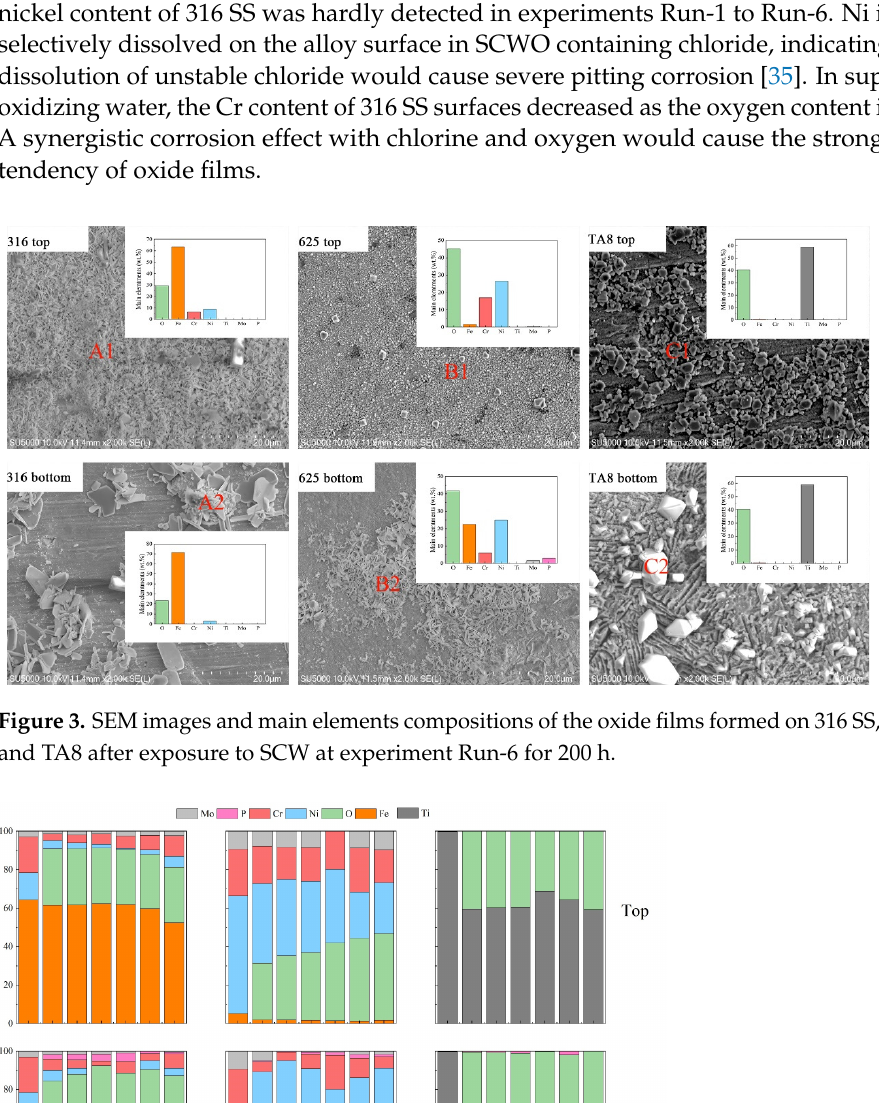
Figure 3. SEM images and main elements compositions of the oxide films formed on 316 SS, Alloy 625, and TA8 after exposure to SCW at experiment Run-6 for 200 h.